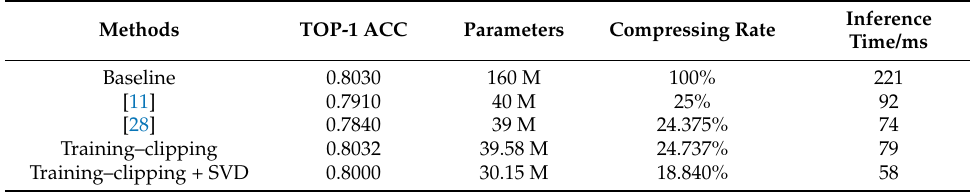
Table 8. Comparison with 8-bit quantization methods.